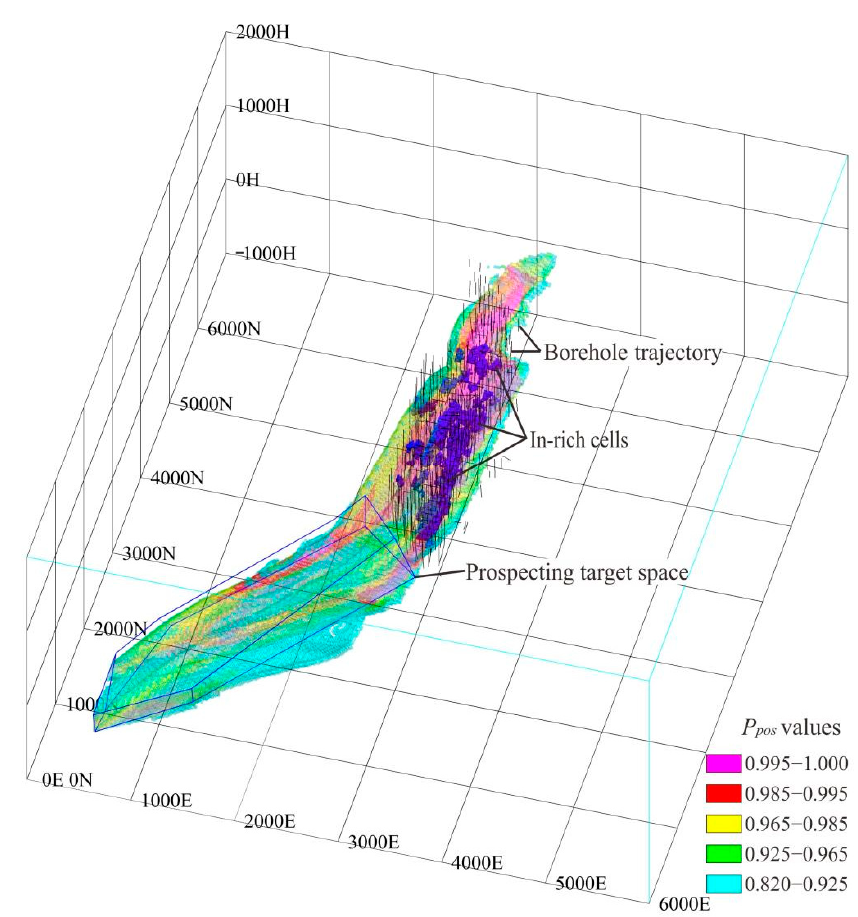
Figure 5. Metallogenic prediction map of weight of evidence method ( 𝑃 (cid:3043)(cid:3042)(cid:3046) > 0.820).